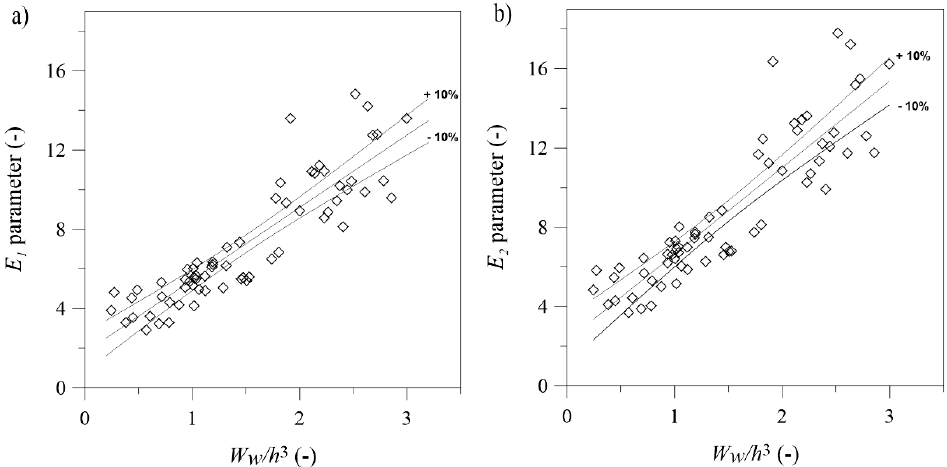
Figure 13. Relative maximum overtopping volume W W / h 3 versus the wave overtopping volume parameter E 1 and E 2 with and without relative wave amplitude, respectively, as well as with 10% deviation (dashed line): ( a ) E 1 according to Equation (5) ( R 2 = 0.80) and ( b ) E 2 according to Equation (7) ( R 2 = 0.80).